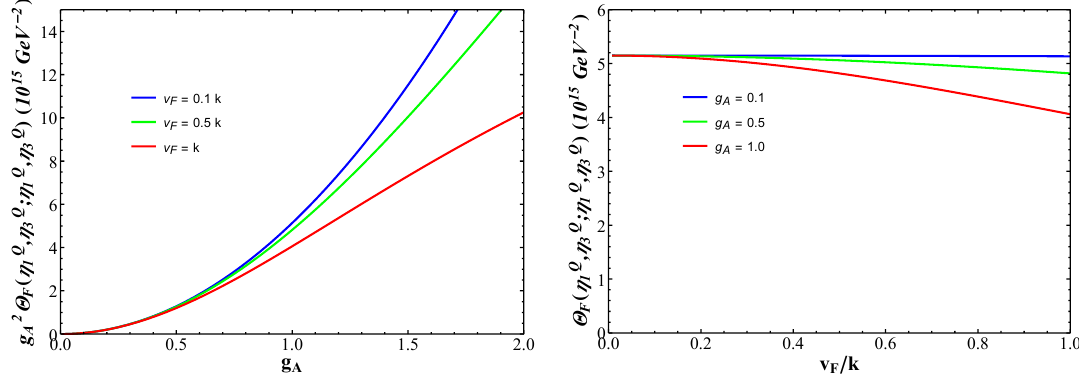
Figure 3. Dependence of g 2 on v F (right), for a sample point in parameter